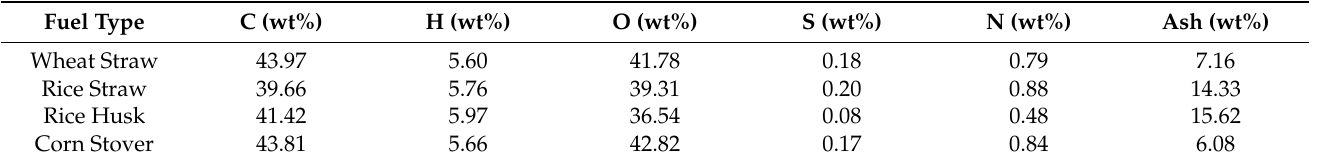
Table 7. Fuel properties of agricultural crop residues.